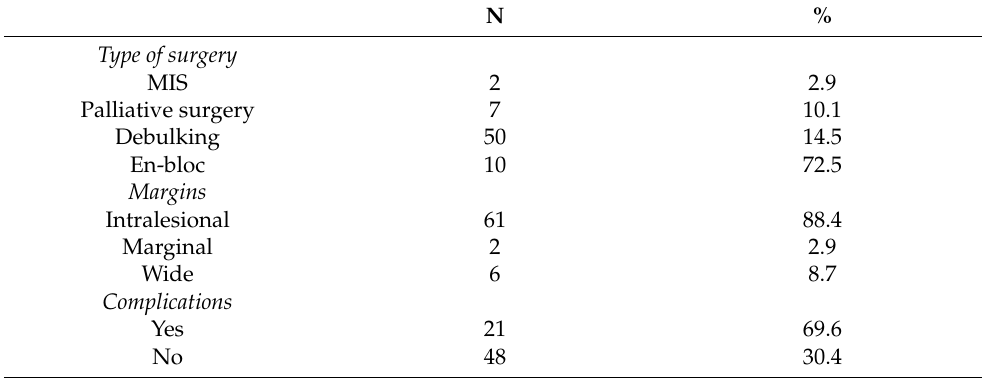
Table 2. Surgery